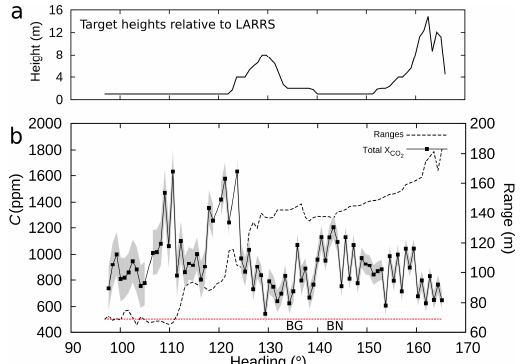
Figure 5. Remote sensing results. ( a ) Height of target relative to LARRS retrieved from Google Earth data; ( b ) 1D CO 2 concentration profiles, i.e., path-averaged mixing ratios, resulting from pivoting the TX/RX unit of LARRS around the sector shown in Figure 1b–d. Note that the mixing ratios are not background corrected. The grey envelope depicts the uncertainty (1 STD). The ambient CO 2 mixing ratio is depicted by the red dotted line. The vents BG and BN are situated at angles ~135 ◦ and ~143 ◦ , respectively.